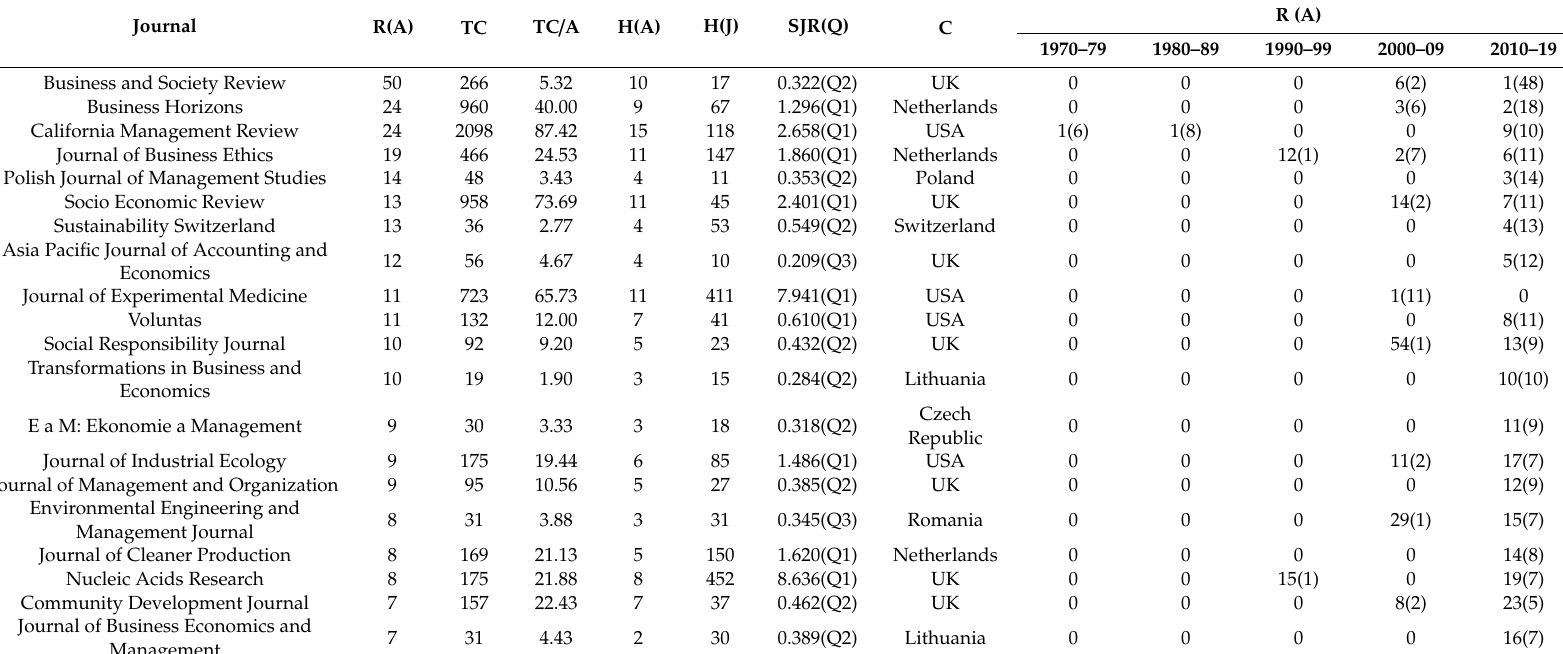
Table 4. The most productive journals in number of articles